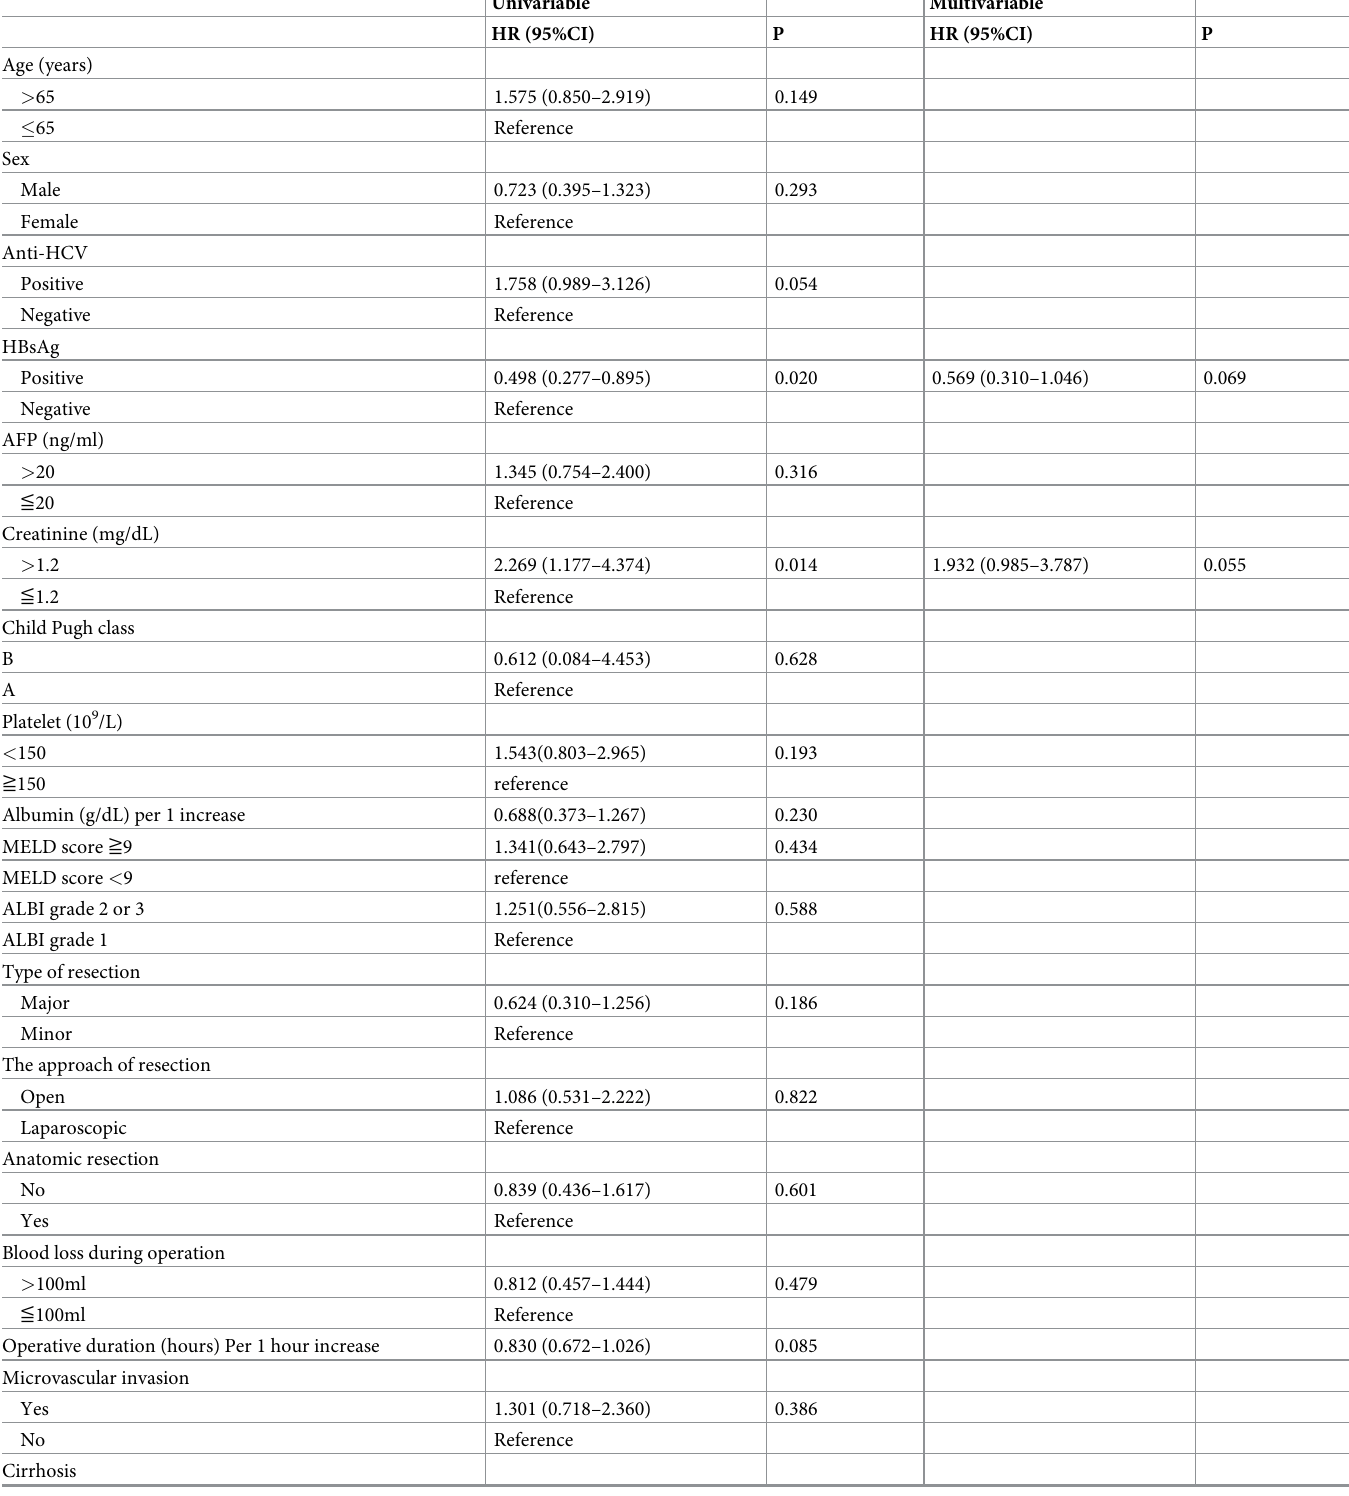
Table 3. Univariate and multivariate analysis of recurrent free